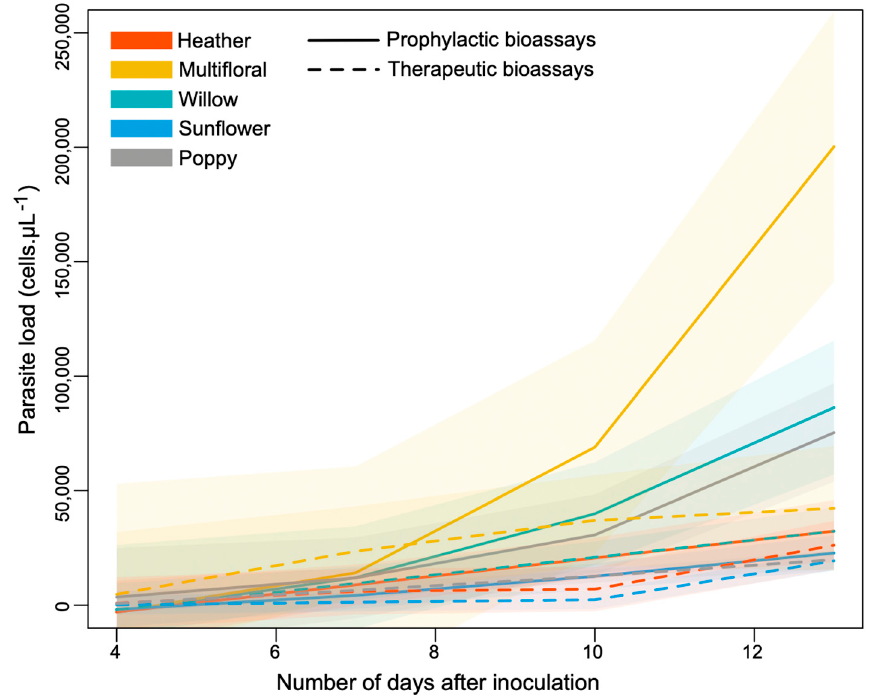
Figure 5. Dynamics of infection within B. terrestris microcolonies. The color code refers to the pollen diet, and the line type refers to the bioassay categories. Generalized additive mixed effect models (GAMMs) were used to fit smoothers to the data showing mean trends ( ± 95% confidence intervals) over time.